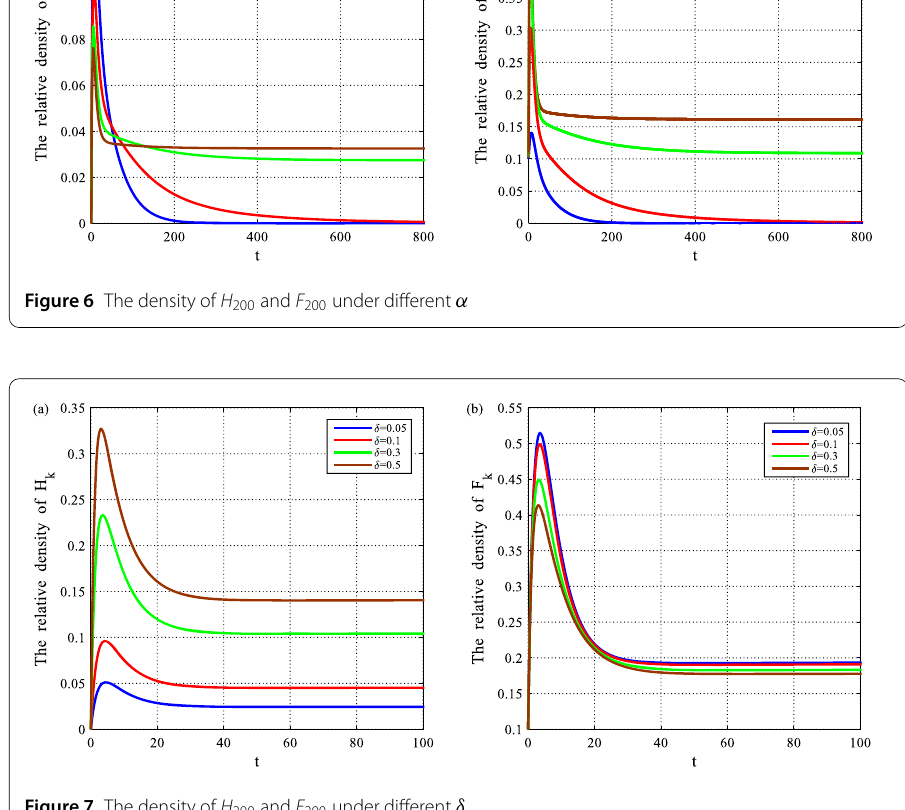
the preferential information. Therefore, reducing the degree of hesitation of the customer, that is, improving the promotion strategy and effective customer service guidance, can promote the spreading of